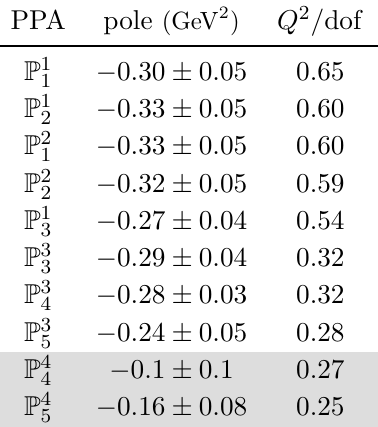
( p 2 ) and P 4 ( p 2 ) do not enter our final values, due to 4 5